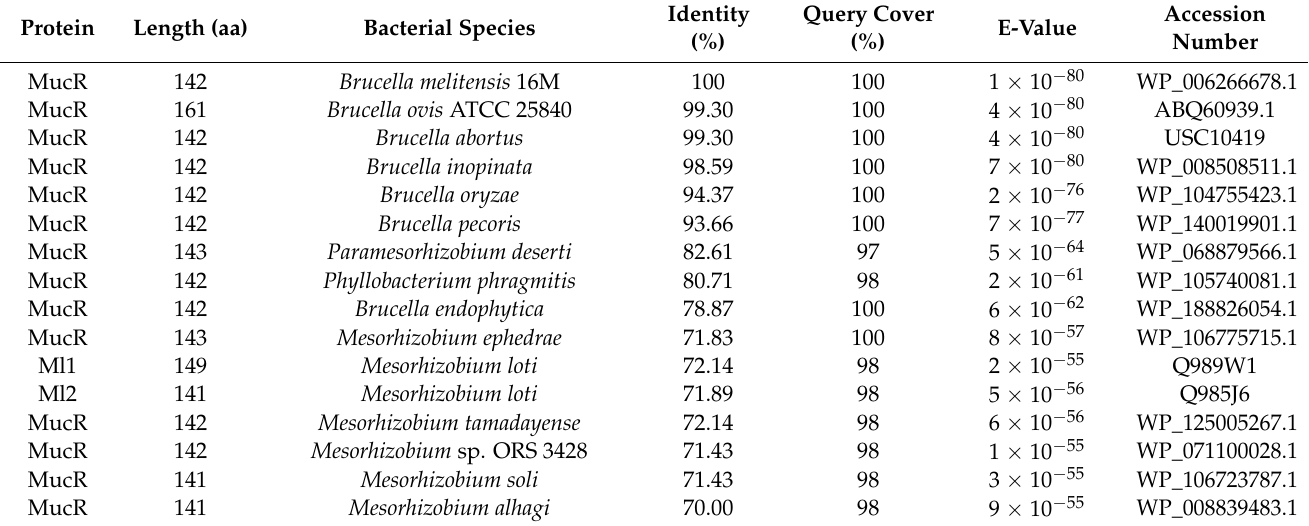
Table 2. MucR proteins and their homology (% identity) among representatives of Brucella and Mesorhizobium genera. The MucR homologs presented here were selected on the basis of their sequence identity